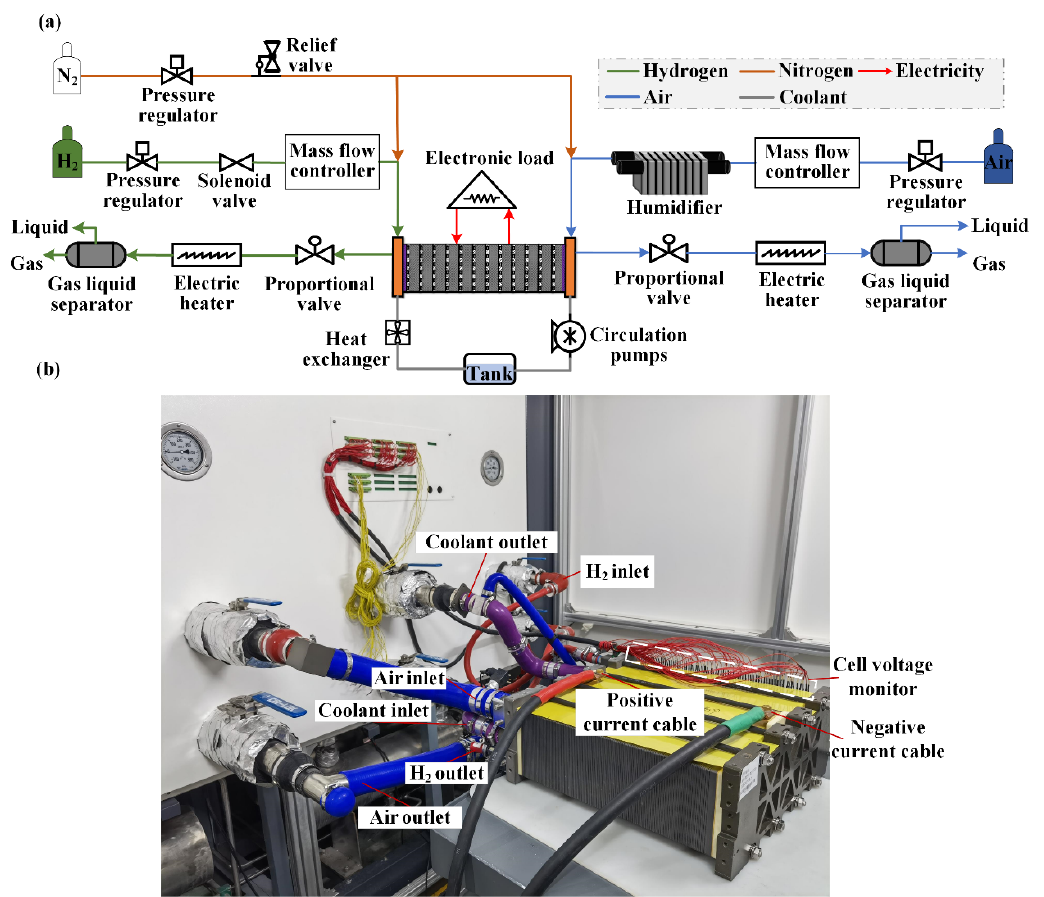
Figure 1. ( a ) Schematic of the fuel cell test system; ( b ) Photo of the 100-cell fuel stack in operation. Table 1. Operating conditions.